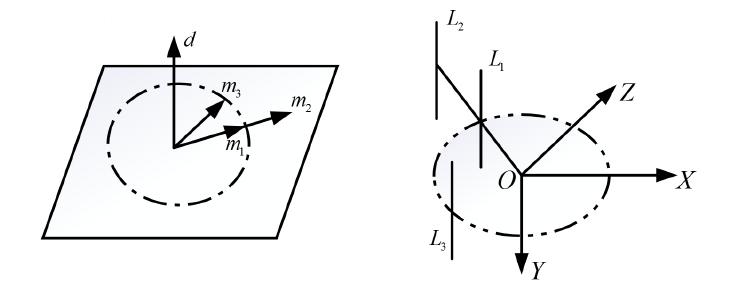
Figure 5. Correspondences of 3D lines and Plücker lines with the same d but different m